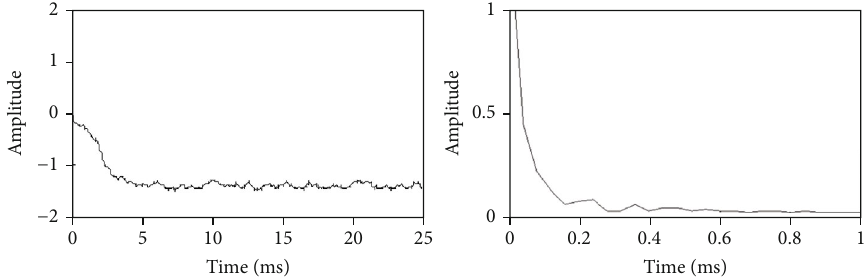
Figure 8: The time and frequency spectrum of the system input and output when a = 3 and b = 0 : 8 .